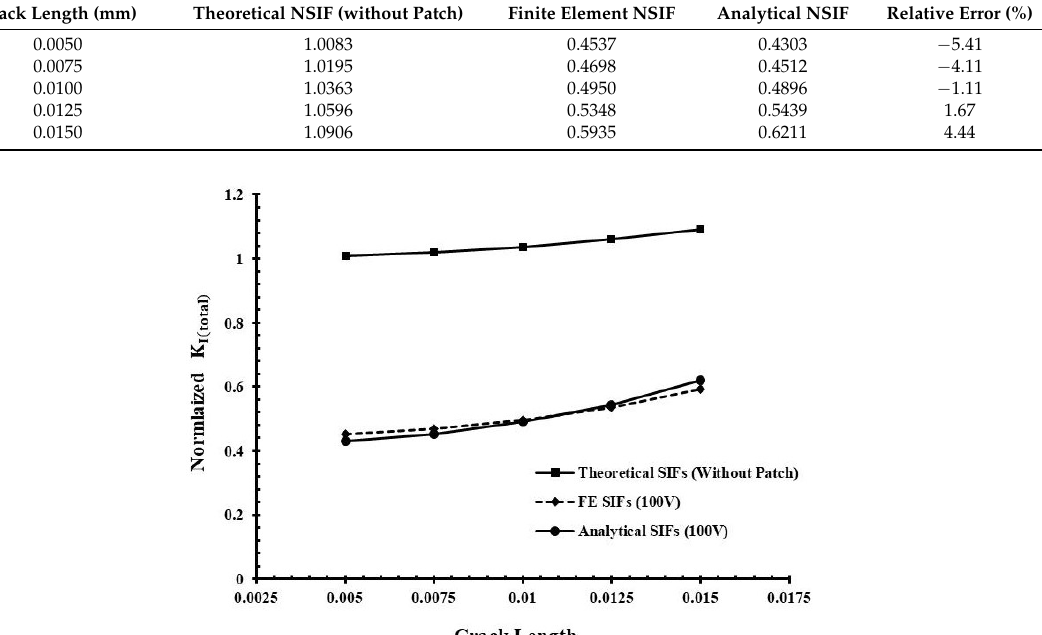
Table 2. Comparison of the NSIFs between unpatched and patched cracks with application of 100 V. Crack Length (mm)